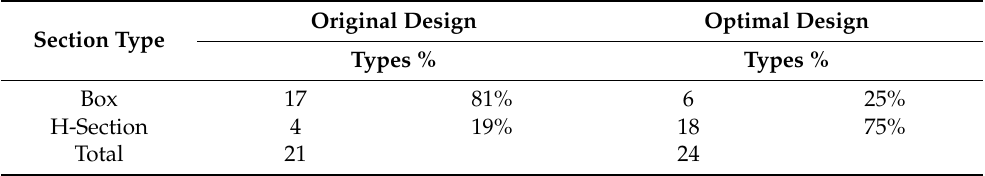
Table 2. Comparison of member section